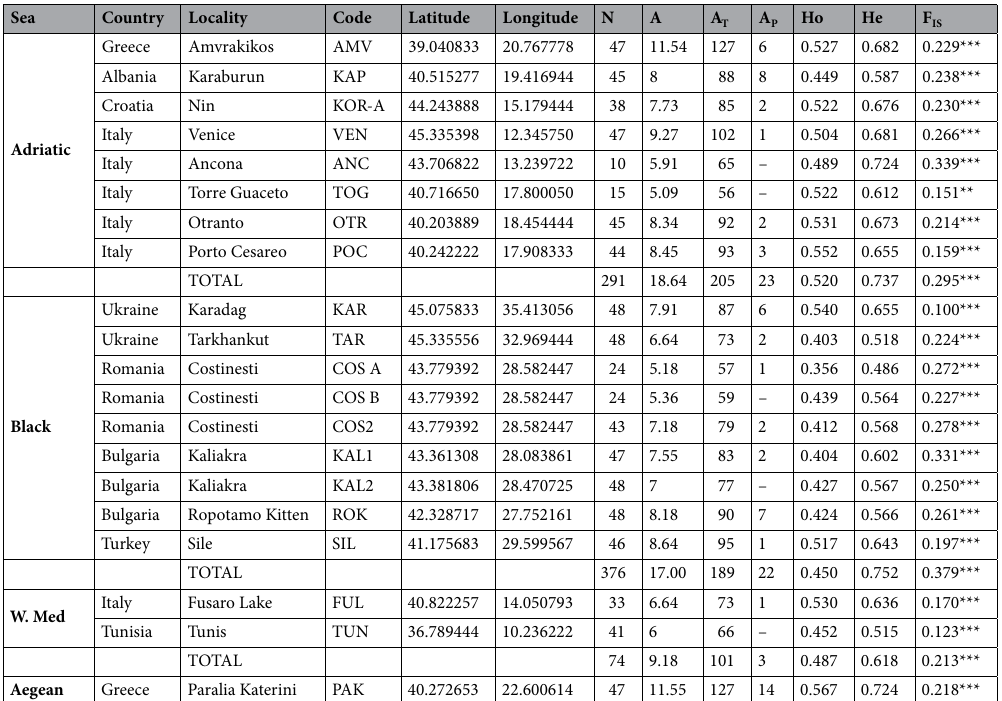
Table 1. Samples of Tritia neritea analyzed in this study and summary statistics. N = number of specimens analyzed; A = mean number of alleles per sample; A T = total number of alleles per sample; A P = number of private alleles per sample; He = non-biased expected heterozygosity; F IS = values of the inbreeding coefficient. Significance of F IS values are given as follows: ***< 0.001; **<